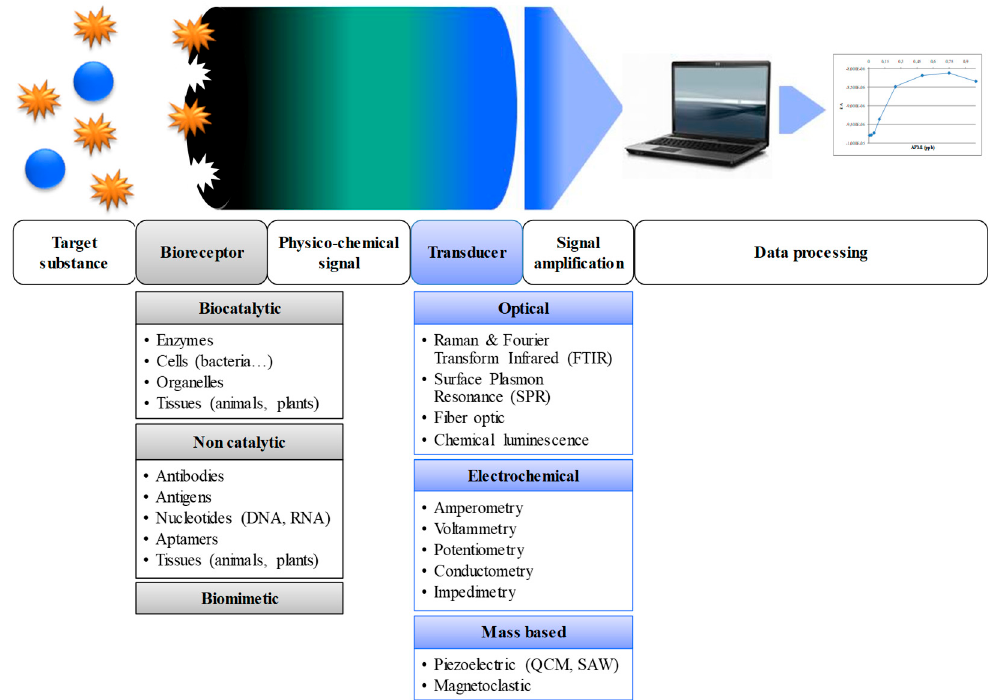
Figure 4. Synoptic representation and classification of biosensors.